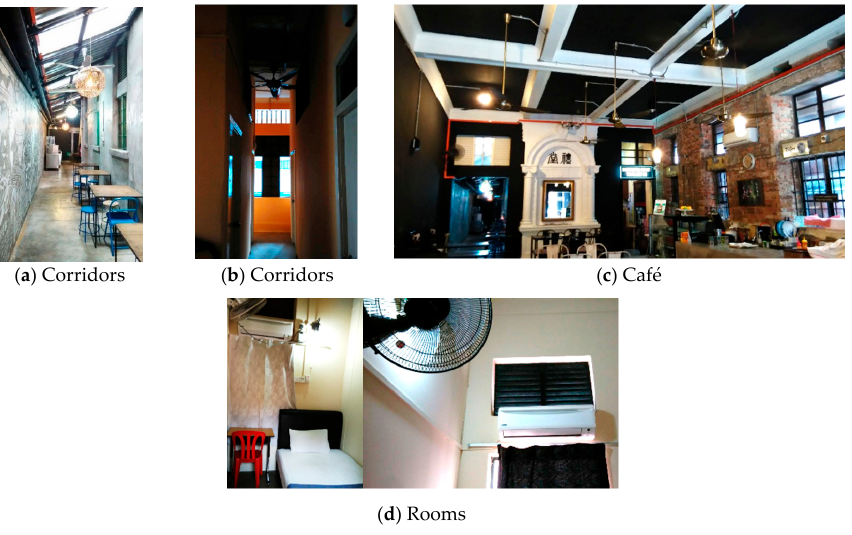
Figure 6. Types of mechanical ventilation in corridors, café and rooms in Building A.